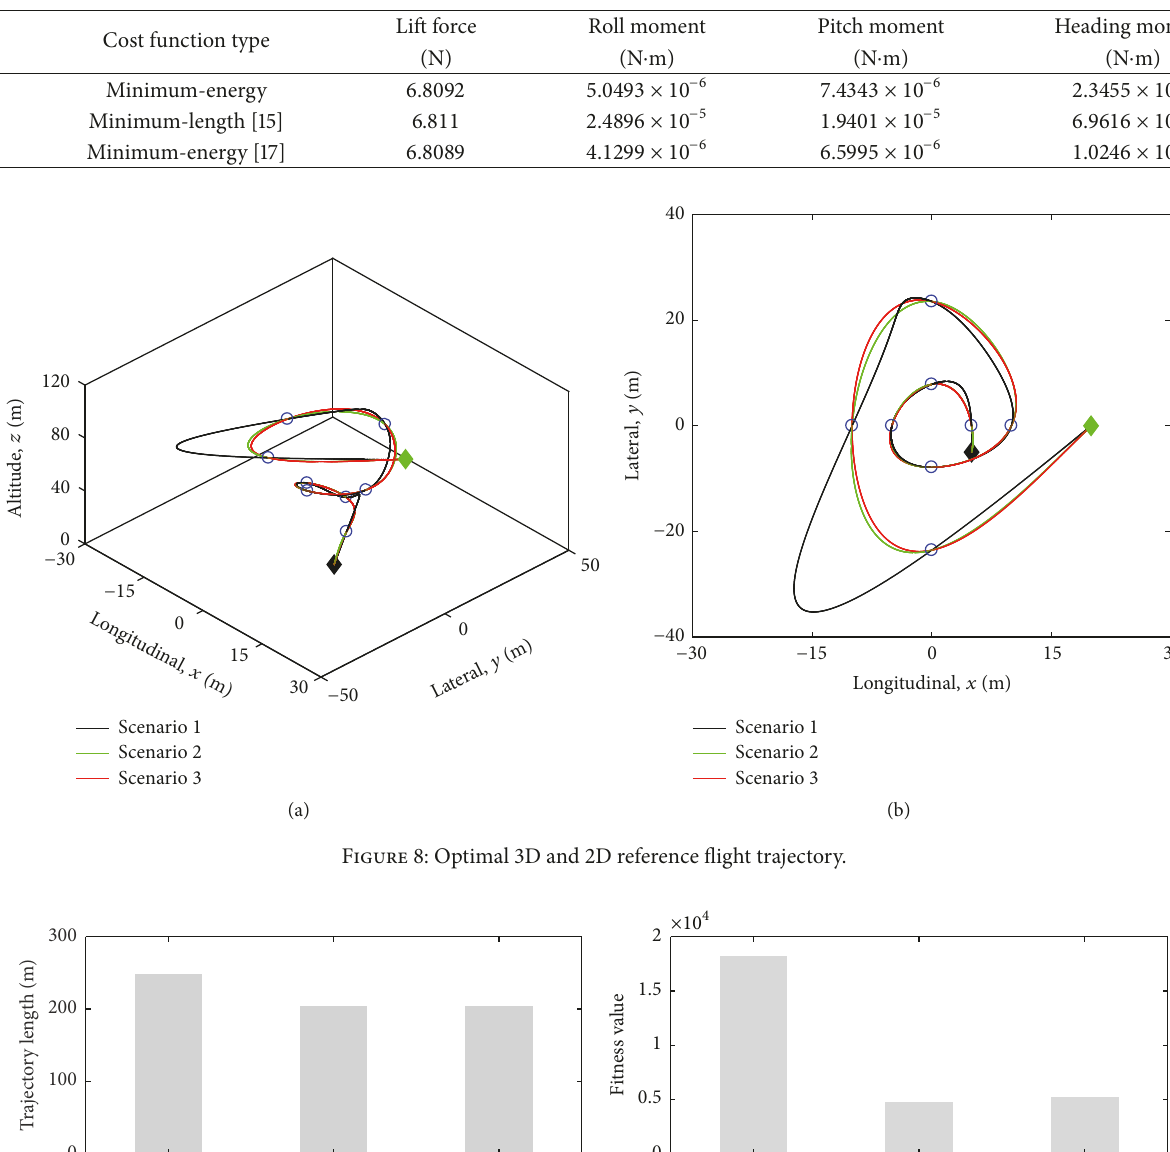
Table 5: Comparison results of induced efforts.